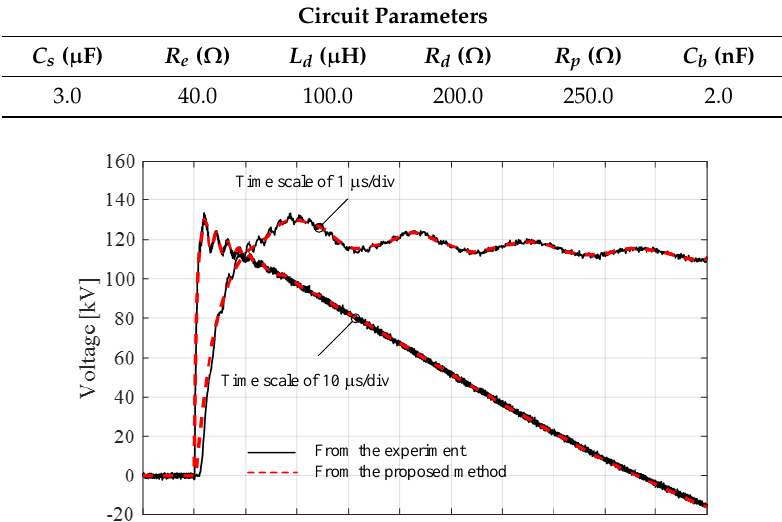
Figure 14. Experimental set up of the completed test system for the lightning impulse test of the reactor, where (1) is the reactor under test, (2) is the impulse voltage generator, and (3) is a voltage divider. Table 3. Selected circuit parameters of the lightning impulse voltage generation circuit.